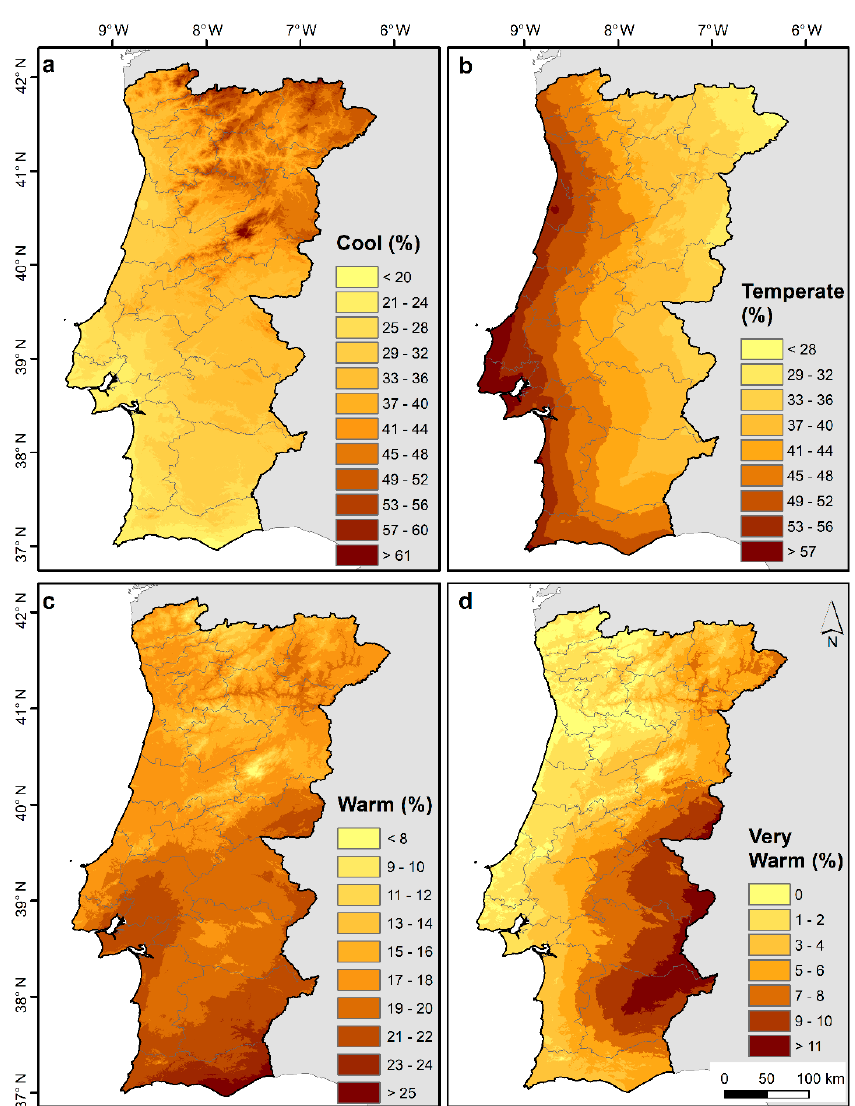
Figure 5. Typical relative number of hours during a year (in %) with ( a ) cool (4–12 °C), ( b ) temperate (12–20 °C), ( c ) warm (20–28 °C), and ( d ) very warm (28–36 °C) conditions over mainland Portugal, for the period of 2000–2018 (cf. Figure 1b for designations of mapped NUTS level 3).